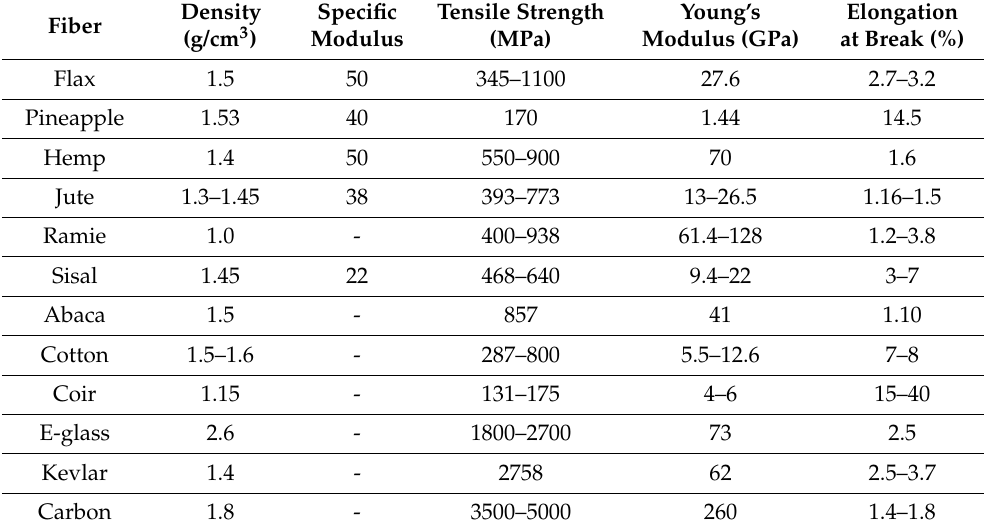
Table 2. Mechanical properties of green fibers